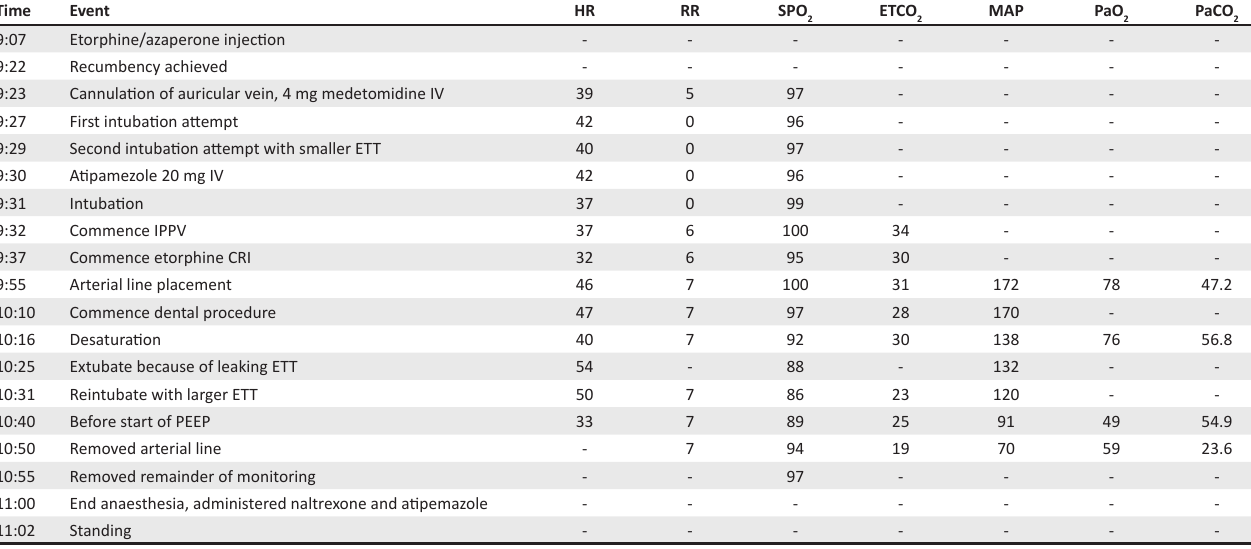
TABLE 1: Cardiorespiratory variables over the duration of the anaesthetic for an elephant anaesthetised with etorphine-azaperone, medetomidine and an etorphine constant rate infusion. Time Event